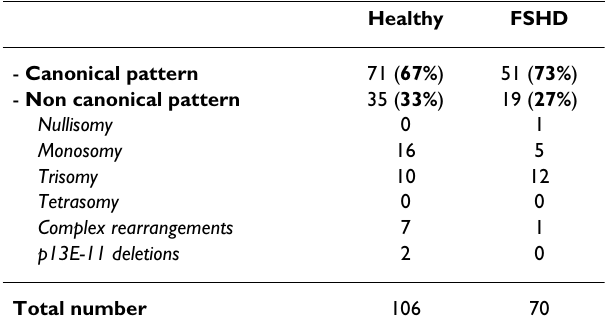
Table 1: Canonical and non canonical patterns in healthy subjects and FSHD patients